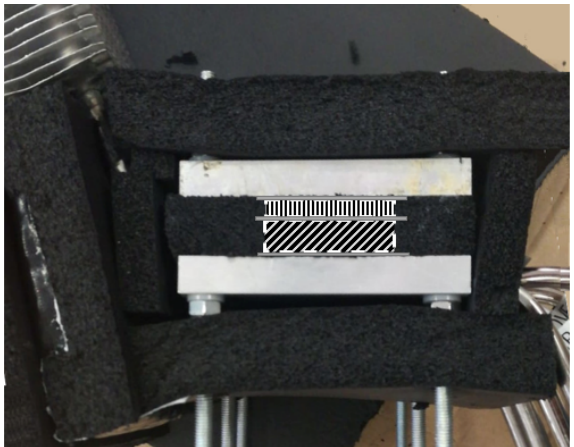
Figure 5. Detail of the neoprene layers installed covering the aluminum plates. On the figure, a drawing of the position of the heat extenders (with diagonal lines), the thermoelectric modules (with vertical lines) and the graphite sheets (in filled gray) has also been